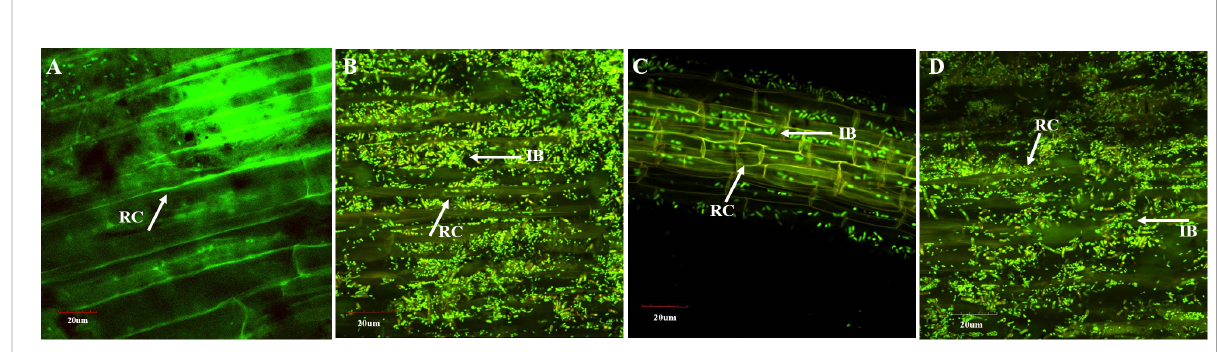
FIGURE 4 Confocal laser scanning microscopy of wheat roots at 35 days after inoculation of consortia in pot experiment under net house conditions. Oligonucleotide probes labeled with FLUOS dye showed green fl uorescent signals for the entire bacterial population in the uninoculated control (A) and in wheat inoculated with consortium-1 (B) , consortium-2 (C) , and consortium-3 (D) . IB, inoculated bacteria; RC, root